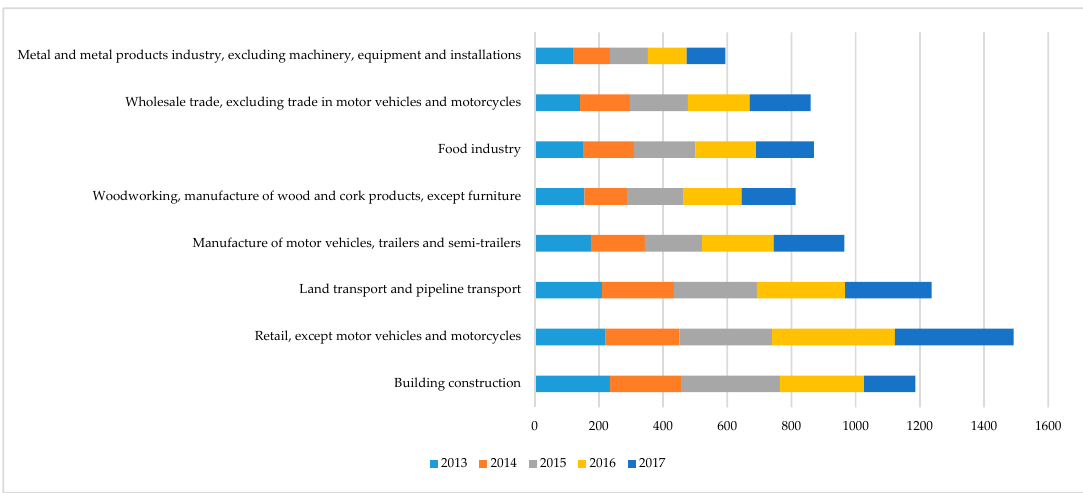
Figure 12. Number of non-fatal accidents in Romania during 2013–2017 [1,2].